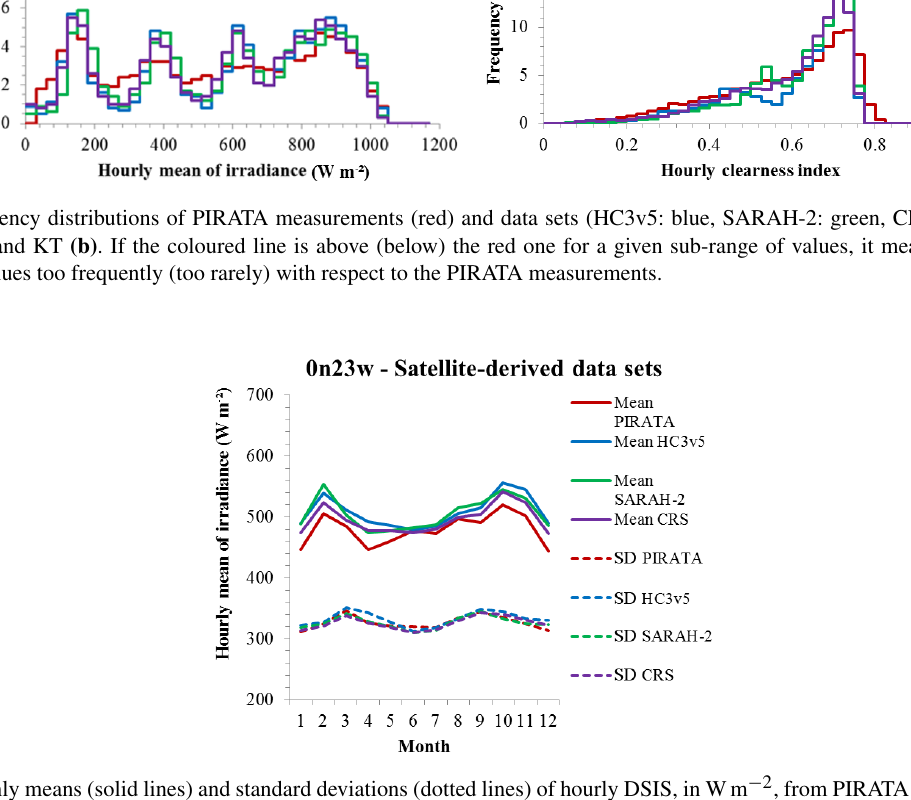
Figure C3. Monthly means (solid lines) and standard deviations (dotted lines) of hourly DSIS, in Wm − 2 , from PIRATA measurements (red) and data sets (HC3v5: blue, SARAH-2: green, CRS: purple) at 0 ◦ N, 23 ◦ W. A difference between red line (measurements) and coloured line (data set) for a given month denotes a systematic error for this month: underestimation if the coloured line is below the red line, overestimation otherwise. For a given month, a coloured dotted line above the red one means that the data set produces too much variability for this month; in the opposite case, the data set does not contain enough